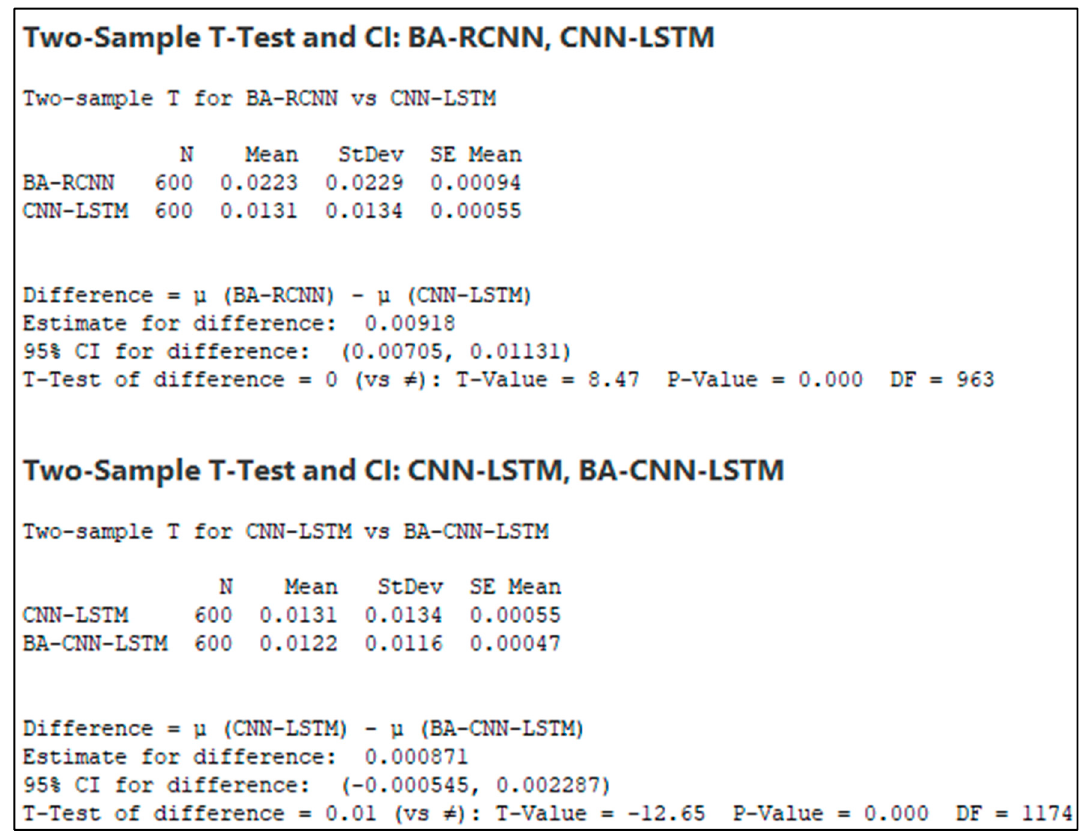
Figure 9. The two-sample t-test between BA-RCNN, CNN-LSTM, and BA-CNN-LSTM algorithms. With a p -value less than 0.05, it meant that the error difference in the testing set was significant between the BA-RCNN and CNN-LSTM and between the CNN-LSTM and BA- CNN-LSTM algorithms. Thus, adding the LSTM network reduced the prediction error significantly. Furthermore, optimizing the LSTM parameters using the BA had a signifi- cant contribution as well in error reduction. The following Figure 10 shows the validation accuracy for all four algorithms within a 0.02 threshold (the acceptable error) using 10-fold cross-validation. The following Table 6 presents the training, validation, and testing average predic- tion accuracies of the 10-fold cross-validations for all algorithms, in addition to the time taken for computations in the best iteration. Table 6. The prediction accuracy and time for percent of porosity (artificial porosity images). BA-RCNN